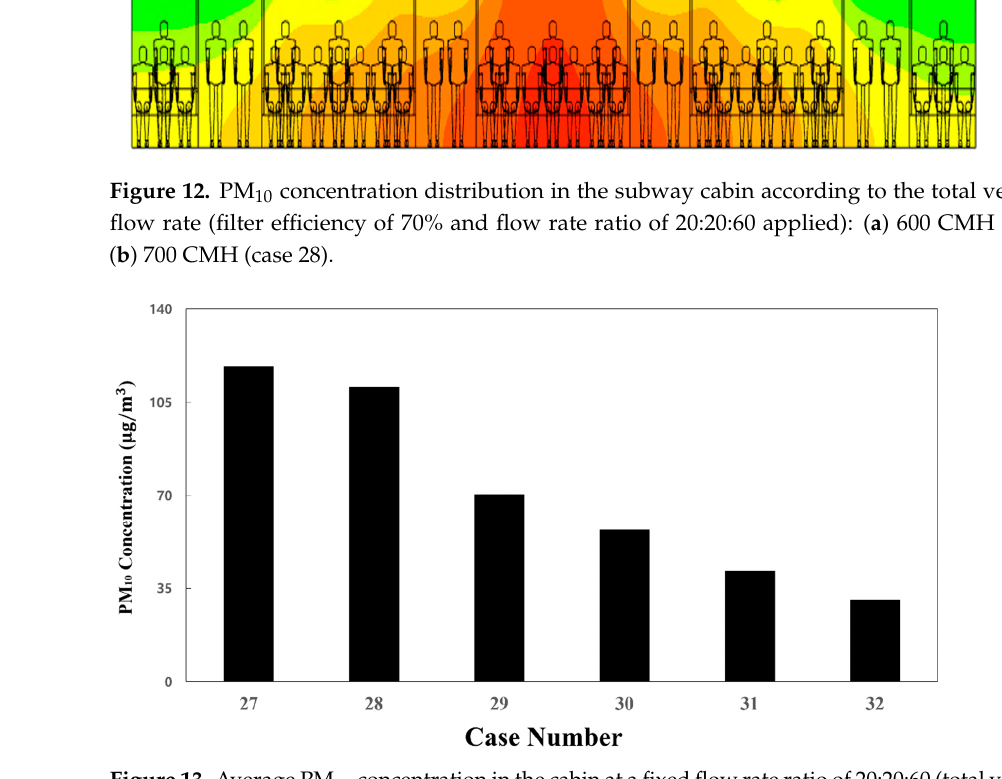
Figure 14. PM 10 concentration distribution in the subway cabin according to the total ventilation flow rate (filter efficiency of 80% and flow rate ratio of 20:20:60 applied): ( a ) 500 CMH (case 2); ( b ) 600 CMH (case 29); ( c ) 700 CMH (case 30).